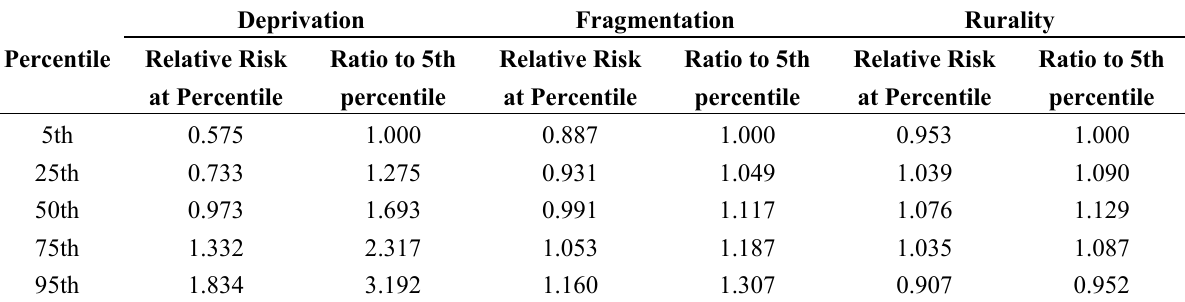
Table 6. Relative risks of self harm at selected percentile points of constructs, under cubic spline regression